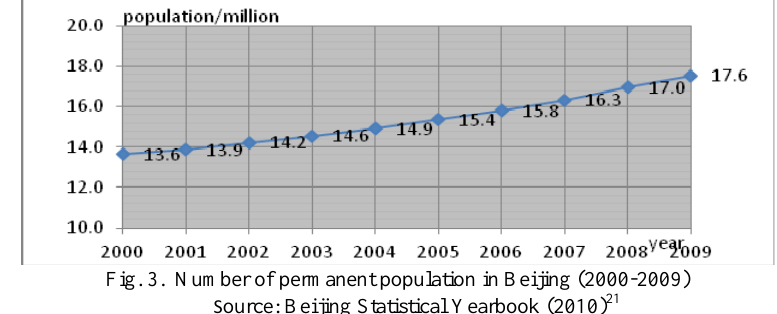
Fig. 3. Number of permanent population in Beijing